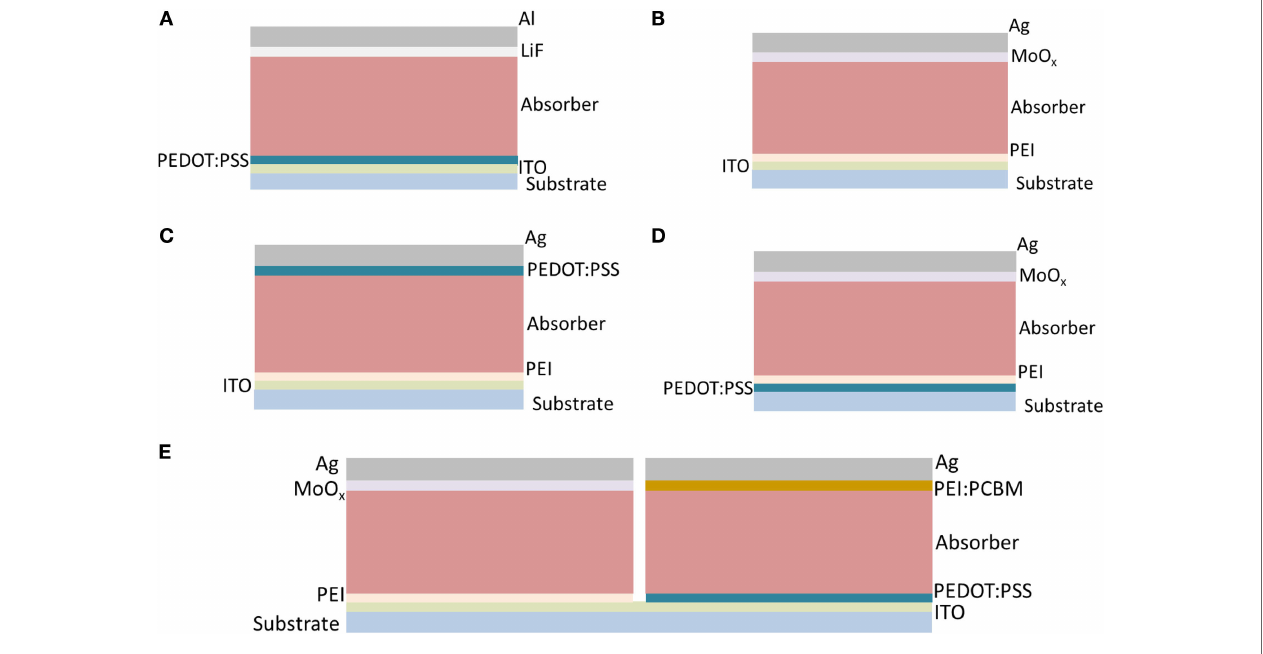
FigUre 3 | (a) Standard device (reference), (B) inverted device with MoO x as hole-selective interlayer, (c) inverted device with PEDOT:PSS as hole-selective interlayer, (D) inverted device with PEDOT:PSS as electron-selective interlayer, (e) inverted and standard device connected through the ITO